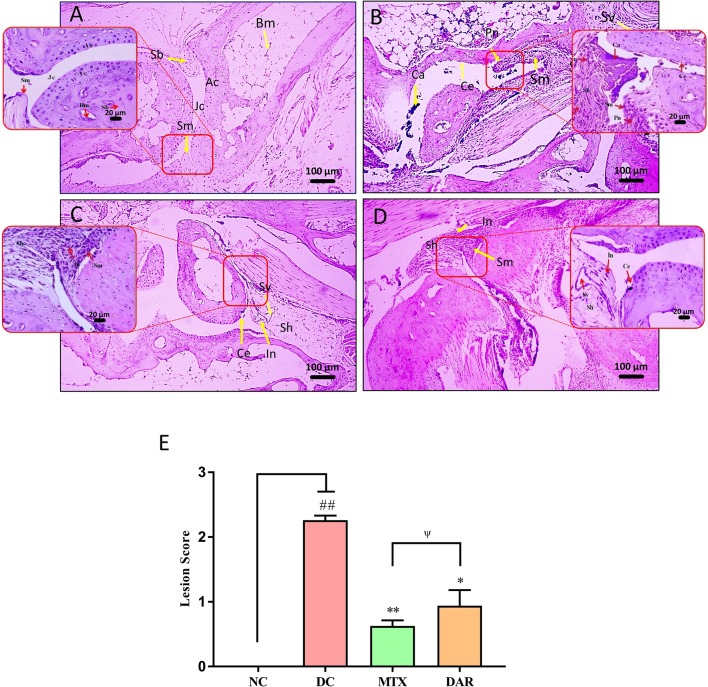
H&E stained histopathological analysis of ankle joints. Histopathological images of H&E stained ankle joints taken at low (100×) and high (400×) magnification showing: (A) NC animal showing synovial membrane (Sm), spongy bone (Sb), bone marrow (Bm), joint cavity (Jc). (B) Collagen-antibody and lipopolysaccharide stimulated DC animal showing moderately enlarged synovial membrane (Sm), hyperplastic synovium (Sh), increased synovial vascularity (Sv), calcinosis (Ca), inflammation (In), pannus formation (Pn), and cartilage erosion (Ce). (C) CAIA animals treated with DAR showed mildly enlarged synovial membrane (Sm), hyperplastic synovium (Sh), and presence of inflammatory cells (In). (D) CAIA animals treated with MTX showed enlarged hyperplastic synovium (Sh), inflammation (In), increased synovial vascularity (Sv), and cartilage erosion (Ce). (E) Total lesion score measurement indicated a decrease in total inflammatory lesion score in the CAIA animals following treatment with DAR and MTX. Non-parametric Kruskal–Wallis analysis was used to calculate the statistical difference in NC versus DC (p-value ## < 0.01), MTX or DAR treatment versus DC (p-value * < 0.05; ** < 0.01), and comparison between MTX and DAR treatments [p-value ψ > 0.05 (non-significant)].